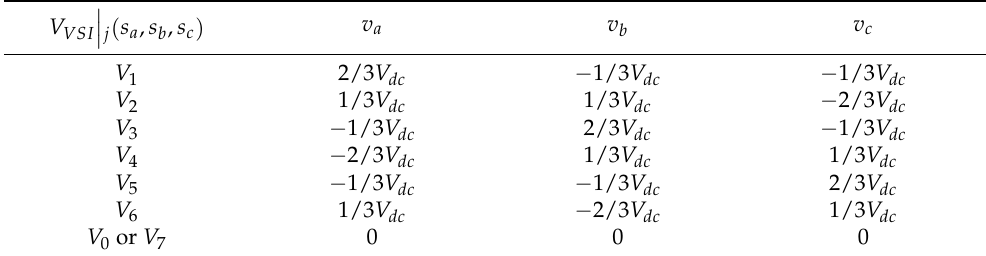
Table 2. Converter